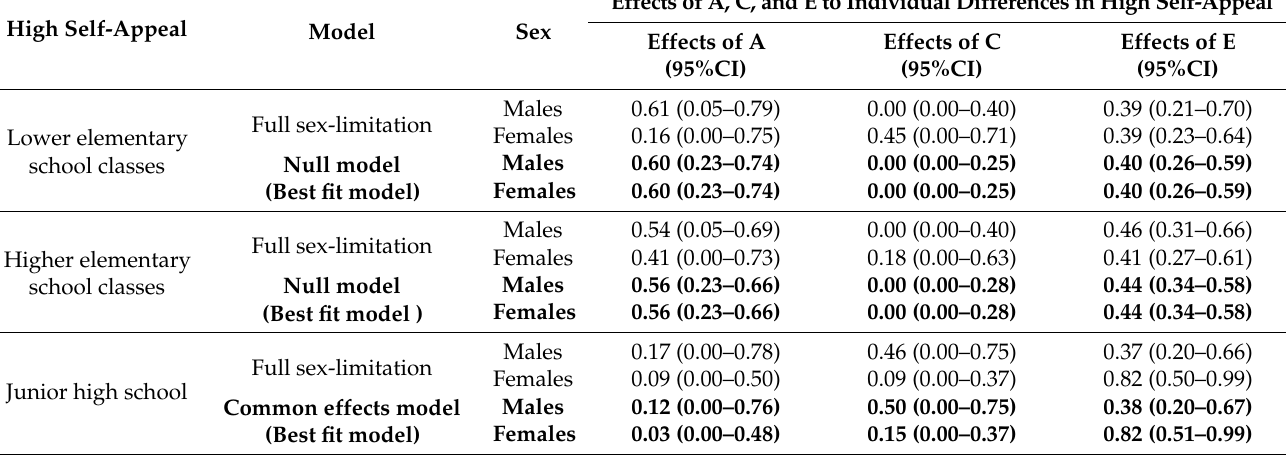
Table 6. Parameter estimates of high self-appeal from sex-limitation model fitting.